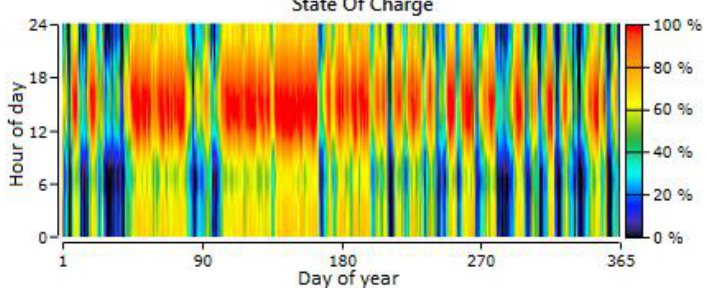
Figure 15. State of charge of the Pumped-hydro storage station.